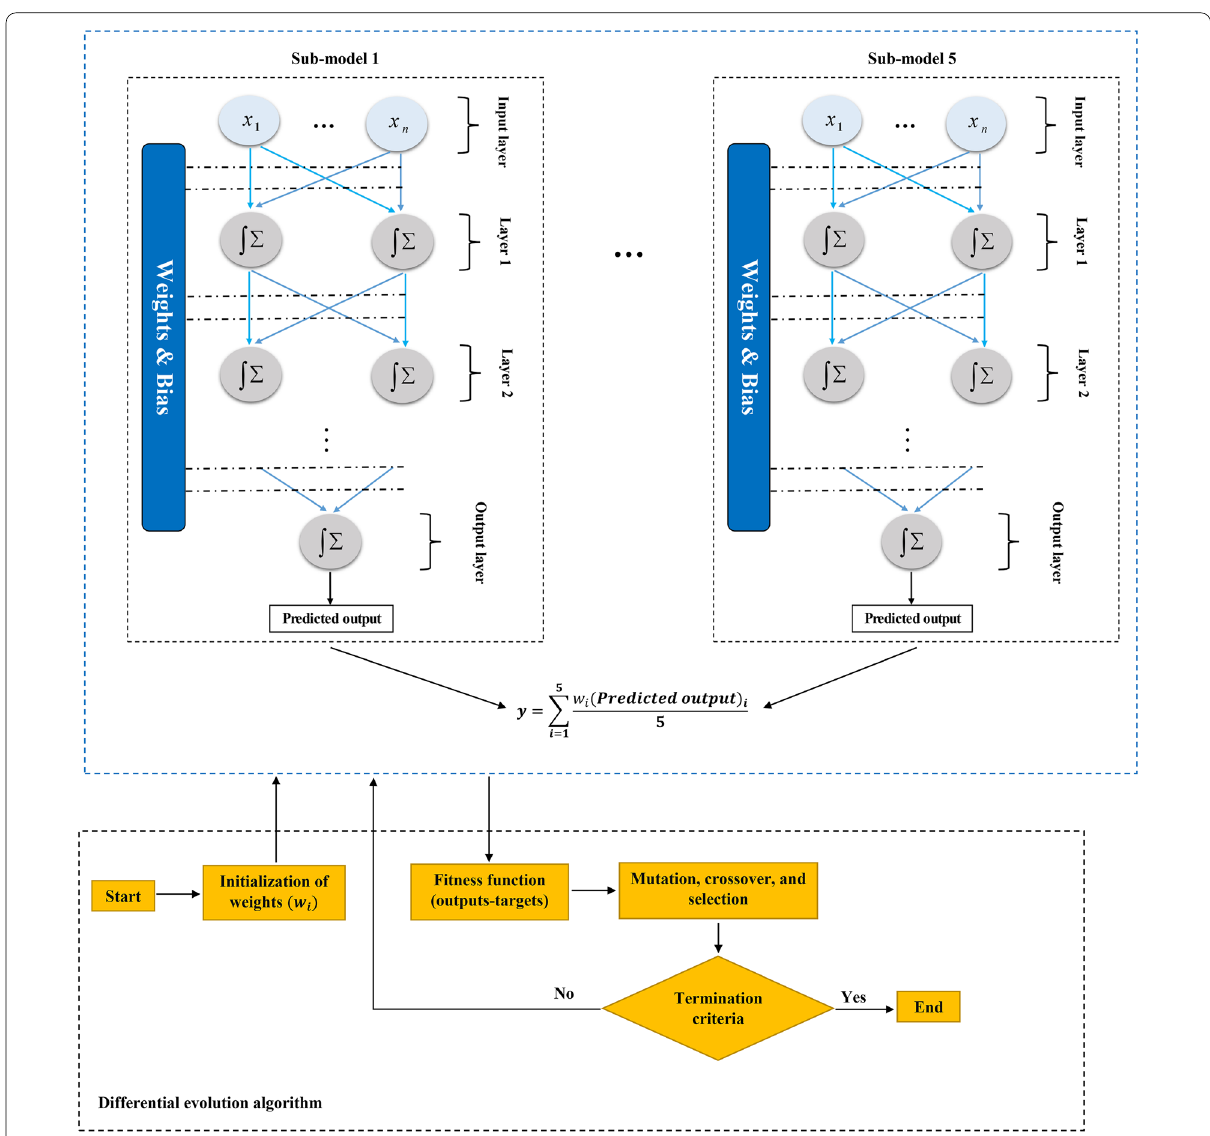
Fig. 6 Flowchart of the WAE method with differential evolution